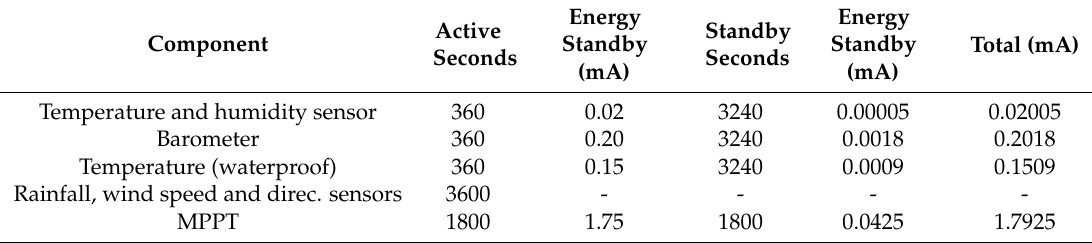
Table 7. Component energy consumption per